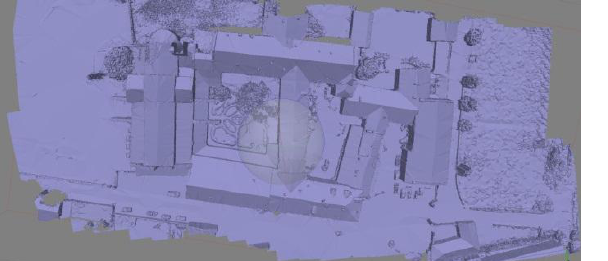
Figure 12. 3DModel visualization (Photoscan)